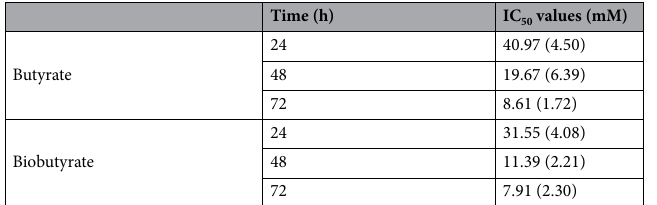
time, apoptotic cells were more frequently to show the pyknosis (shrinkage) and condensed chromatin (brighter nuclei). In contrast, the uniform but low intensity of fluorescence was detected for untreated cells. The quantita- tive analysis showed that the percentage of cells undergoing apoptosis reached around 50% after 10 mM biobu- tyrate was treated for 48 h (Fig. 4B). The analysis of apoptotic cells was further conducted with the dual AO/EB staining. As examined by a fluo- rescence microscope, the nucleus of early-stage apoptotic cells was stained yellow-green and the fluorescence localized asymmetrically within treated cells. The signal of yellow-green fluorescence increased with the increas- ing dose of biobutyrate (Fig. 4C). Late-stage apoptotic cells clearly appeared upon the treatment of biobutyrate with a dose exceeding 5 mM. Their nuclei were marked with the orange-concentrated fluorescence. The implementation of the Annexin V-FITC staining enables identification of apoptotic cells with the exter- nalization of phospholipid phosphatidylserine residues. The quantitative assessment of apoptosis was determined by flow cytometry. The analysis revealed that biobutyrate induced early and late phase of apoptosis in treated HT29 cells (Fig. 4D,E). The distribution of untreated cells was mostly in Q3 (live cells). However, the cell distri- bution in Q2 (late apoptotic cells) and Q4 (early apoptotic cells) increased after biobutyrate was administrated. In general, the cell distribution in Q2 and Q4 increased in a dose- and time-dependent manner. The total apop- tosis rates of biobutyrate (10 mM)-treated and control cells at 24 h were 11.2% (Q2:6.3%, Q4: 4.9%) and 6.7%